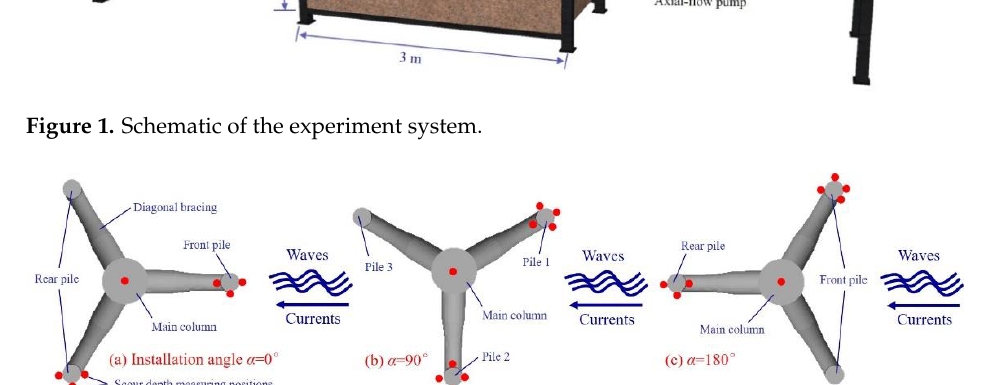
Figure 2. Schematic of tripod with different installation angles.